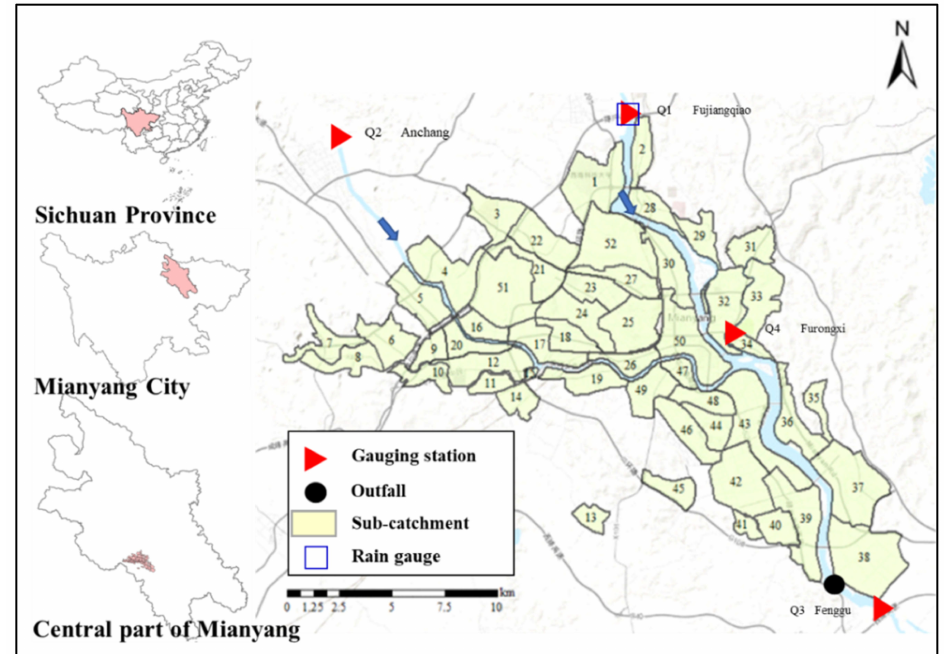
Figure 2. Location map of study area: central part of Mianyang